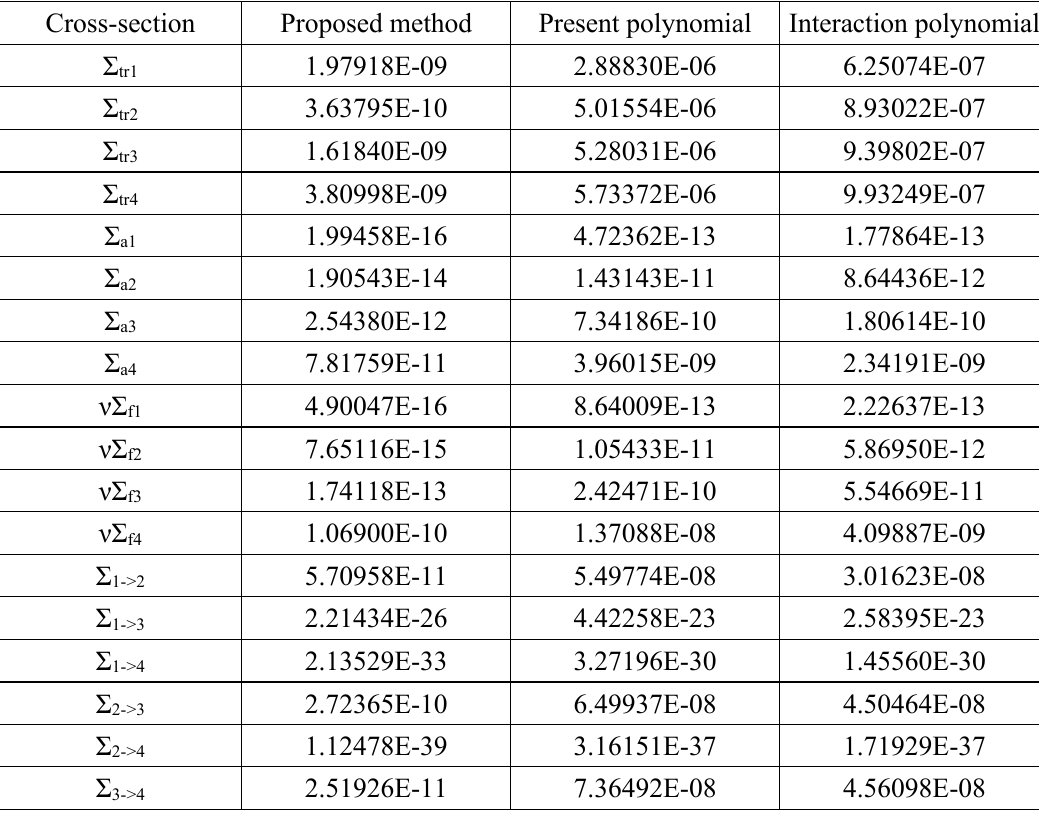
Table I. MSE results of three